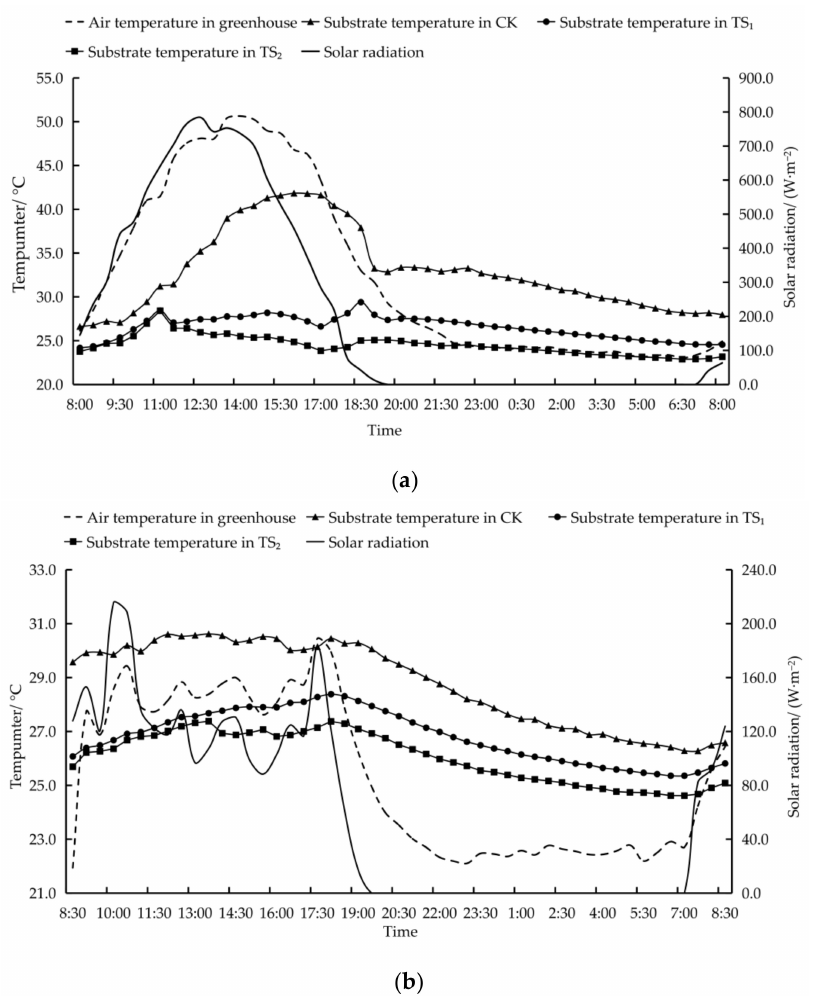
Figure 4. The variation of the substrate temperature under typical weather conditions. ( a ) Sunny day; ( b ) cloudy